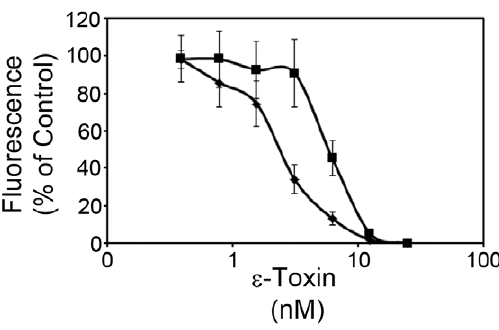
Figure 1. Gene-trap mutagenesis. Wild-type MDCK ( X ) and a CAV2 mutant cell line ( & ) isolated by gene-trap mutagenesis were incubated with serial dilutions of toxin (0–25 nM toxin) at 37 u C. Cytotoxicity was determined as described in Materials and Methods. Results were normalized to the fluorescent signal from untreated cells (100%) and cells treated with 1% Triton (0%). Results represent the mean and standard deviation of quadruplicate samples. The mean toxin dose needed to kill 50% of cells was calculated by non-linear regression analysis of results from at least three different experiments (2.7 nM and 6 nM for wild-type and CAV2 mutant cells, respectively). Values were compared by Student’s t-test. The CAV2 mutant cell line required a greater amount of toxin to kill 50% of the cells than was required to kill 50% of the parental MDCK cells (P , 0.00005).